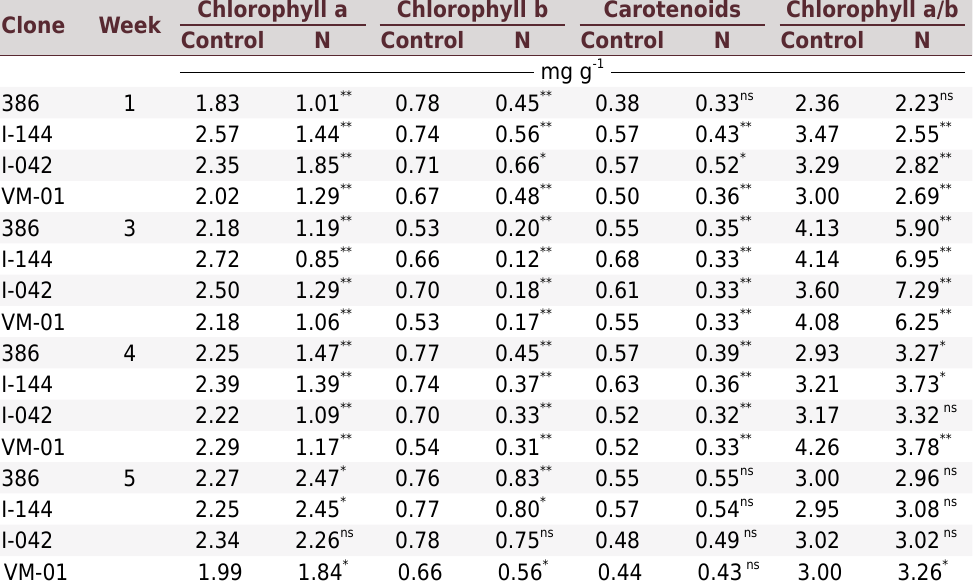
Table 5. Chlorophyll a, b and carotenoids, and chlorophyll a/b in leaves of four Eucalyptus clones (386, I-144, I-042, and VM-01) subjected to nitrogen omission (weeks 1 and 3) and nitrogen resupply (weeks 4 and 5) and control treatments, grown in nutrient solution